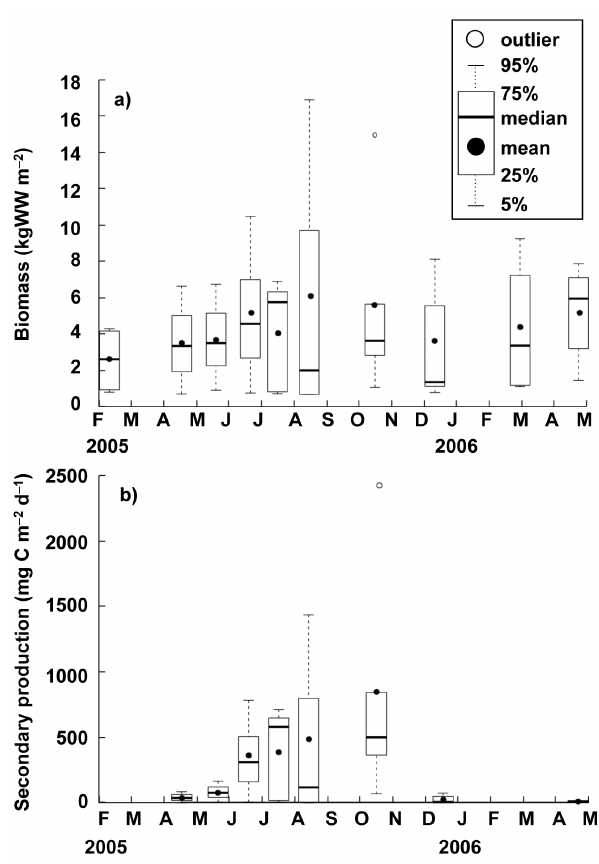
Figure 5. Seasonal variation of the clam ( Ruditapes philippi- narum ) population at tidal flats stations. (a) biomass (kgWW m –2 ) and (b) secondary productivity (g C m –2 d –1 ) of the clam at five tidal flat stations, expressed as box plots.